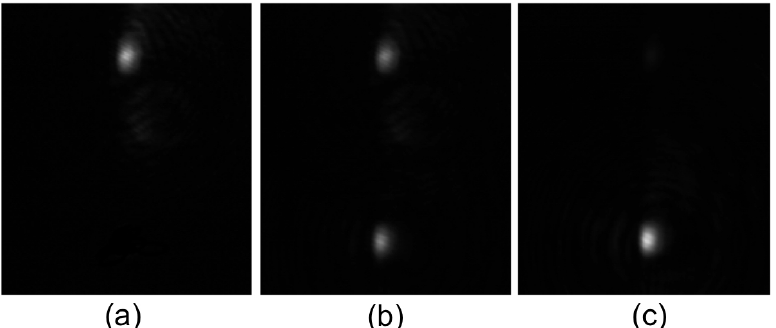
Figure 17. Experimental outputs for different input states to a coupler X π /4 . ( a ) Input state: √ √ | α / 2 − i α / 2 (cid:105) ; output state: | α 0 (cid:105) ; ( b ) input and output states: | α / √ √ | α / 2 i α / 2 (cid:105) ; output state: | 0 α (cid:105)